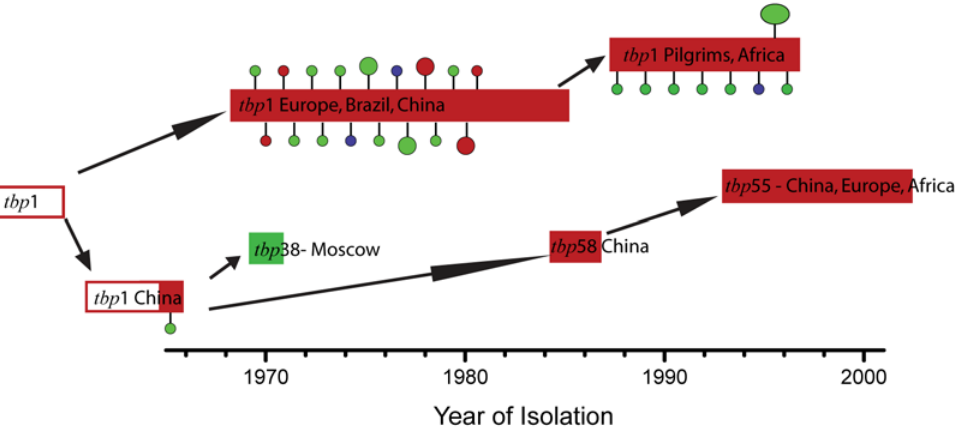
Figure 1. Acquisition of new tbpB genes by subgroup III Neisseriameningitidis during epidemic spread. Colours indicate the family of each tbpB allele, with red corresponding to family 4, green corresponding to family 1, and blue corresponding to family 3. The bars highlight the time frame, most common tbpB type, and geographical extent of each epidemic (in 1987, pilgrims from the Hajj pilgrimage briefly distributed the lineage worldwide). The circles correspond to variant genotypes. Small circles indicating that the variant allele was found in only one strain; large circles indicate it was found in between two and four strains.